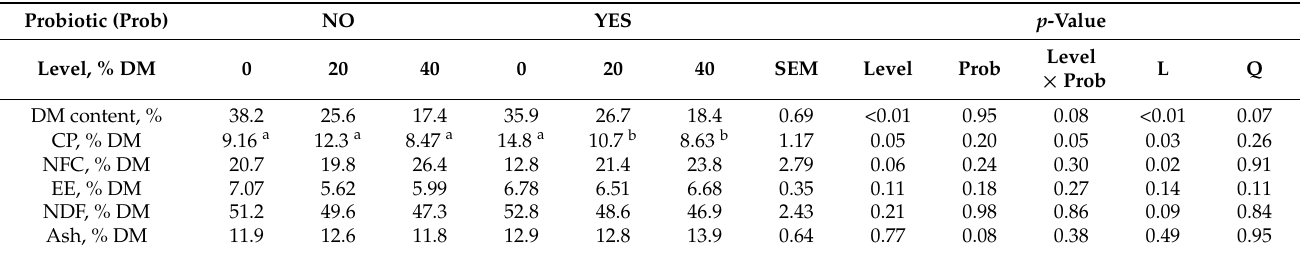
Table 1. Dry matter (DM) content and chemical composition of sorghum-vegetable mixture silages containing 0, 20, or 40% vegetable mixture on a DM